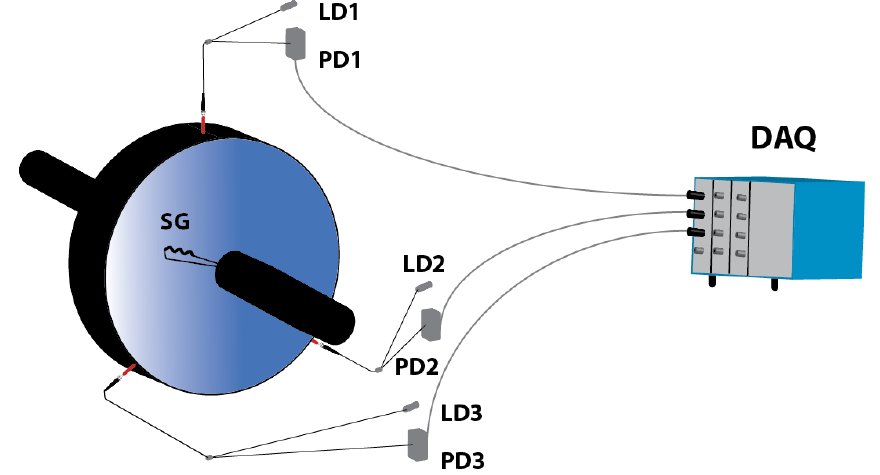
Figure 3. Experimental set-up for the TC measurements in the wind tunnel. LD x stands for Laser Diode x, PD x for Photodetector x, SG for Strain Gauge, and DAQ for Data Acquisition System.